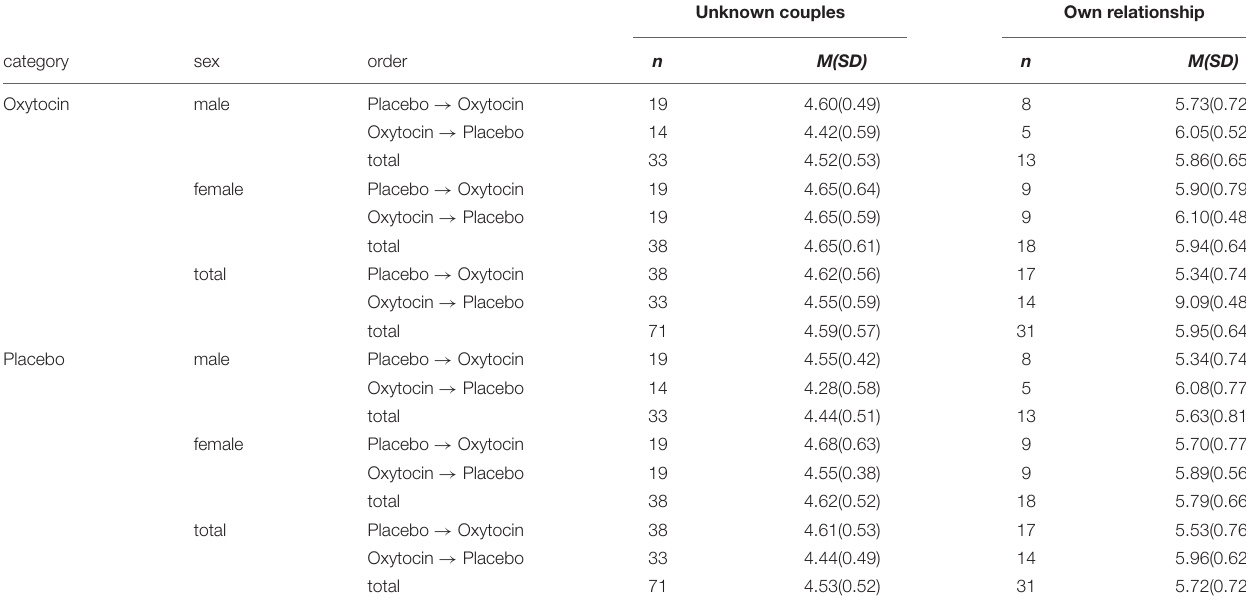
TABLE 2 | Couple Appraisal Task (CAT) Ratings ∗